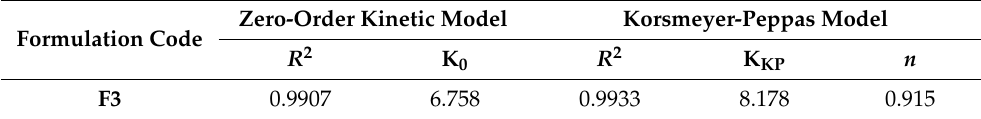
Table 4. Mathematical data of zero-order kinetics and Korsmeyer-Peppas model. Formulation